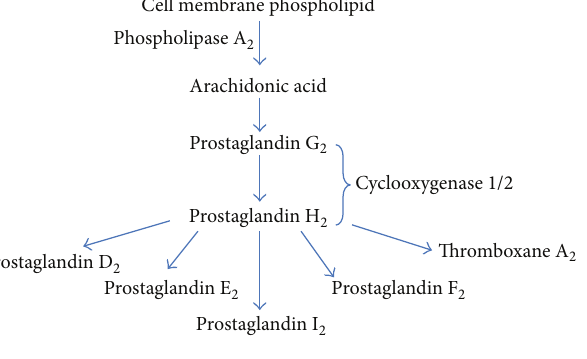
Figure 3: Prostanoid metabolism.